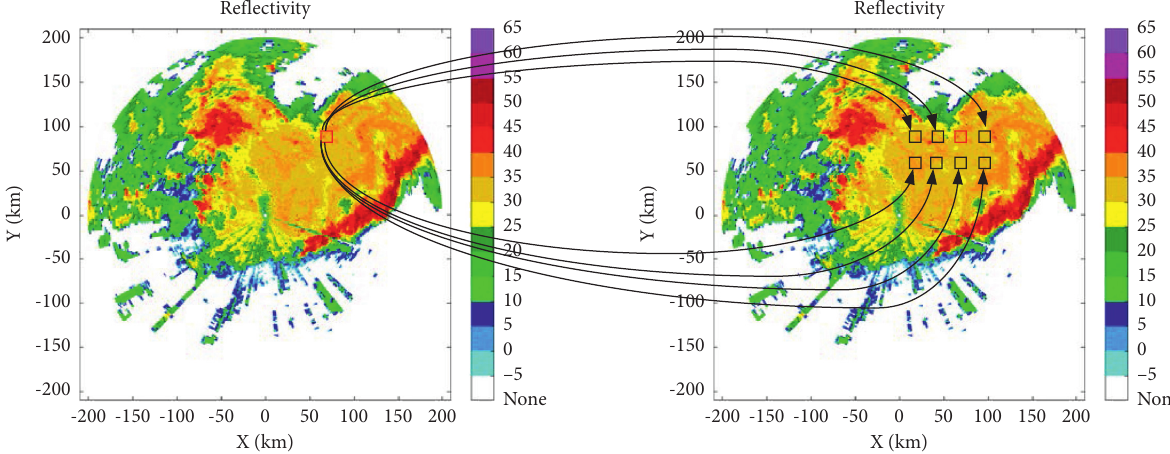
Figure 2: Example of nonlocally similar weather radar image patches.